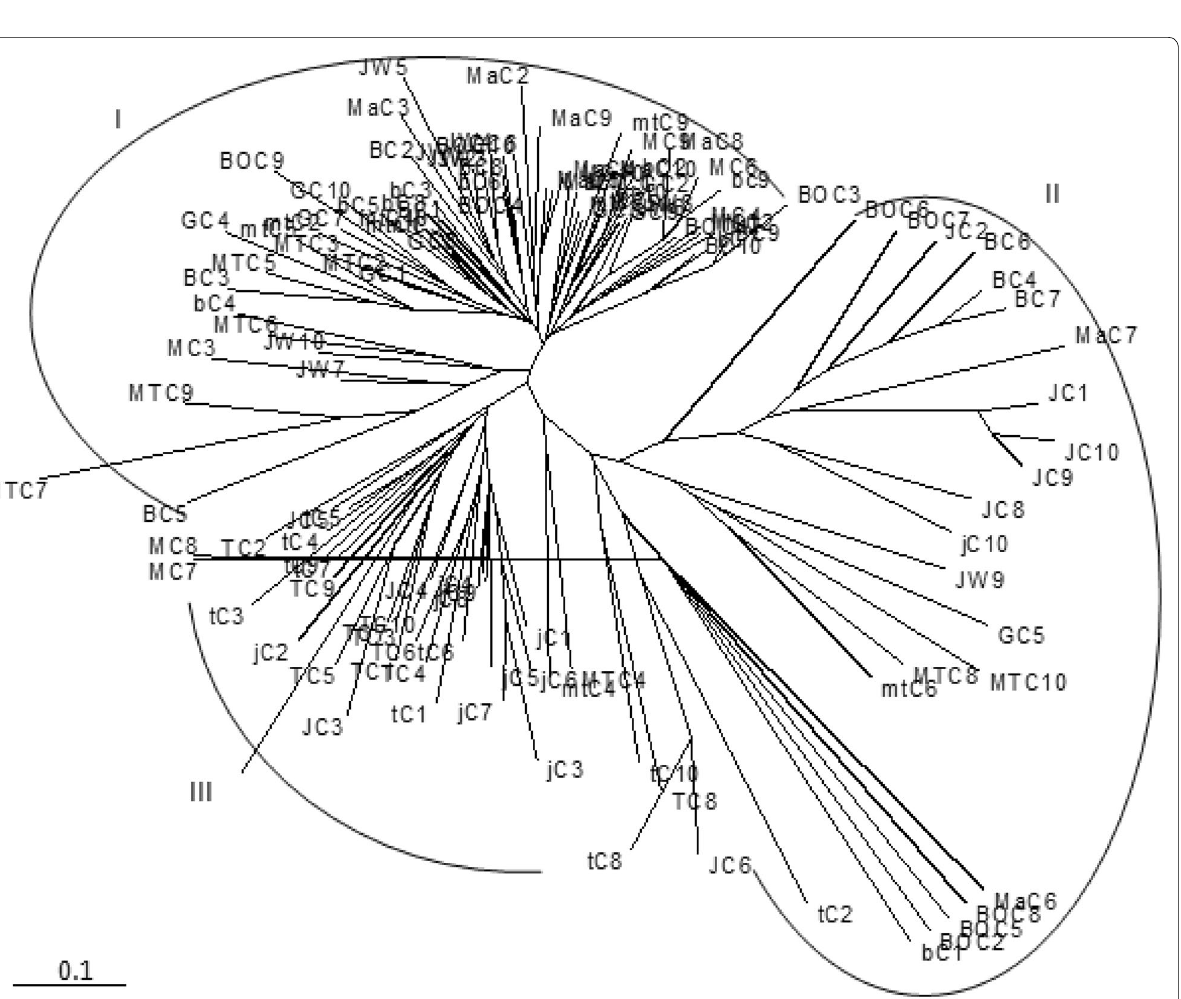
(A) Without grouping the populations, (B) by grouping the populations based on regions and (C) by grouping the populations according to zones of origin AP among population, WP within population, AR among region, APWR among population within region, WR within region, AZ among zone, APWZ among population within zone, WZ within zon, F ST the variance among subpopulations relative to the total variance, F SC the variance among subpopulations within groups, F CT the variance among groups relative to the total variance